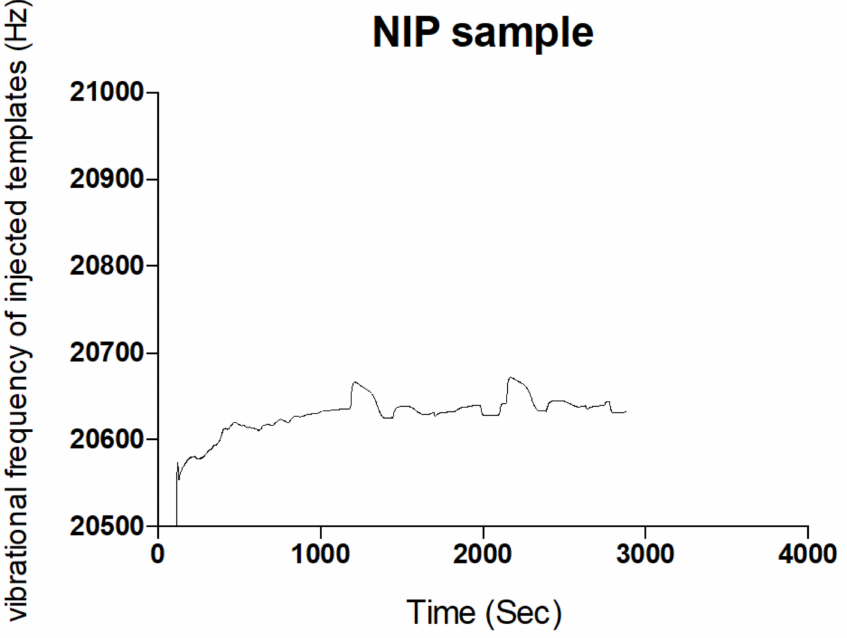
Figure 3. Sensogram of non-rebinding activity of NIP sample from the fluid injection